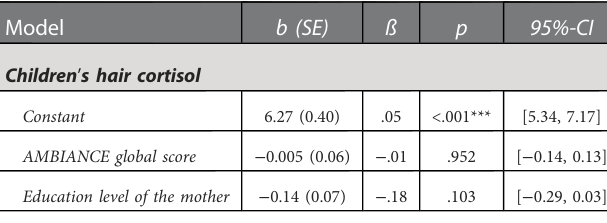
TABLE 2 Results of robust multiple linear regression with AMBIANCE global score as predictor for child ’ s hair cortisol level and maternal education as covariate.